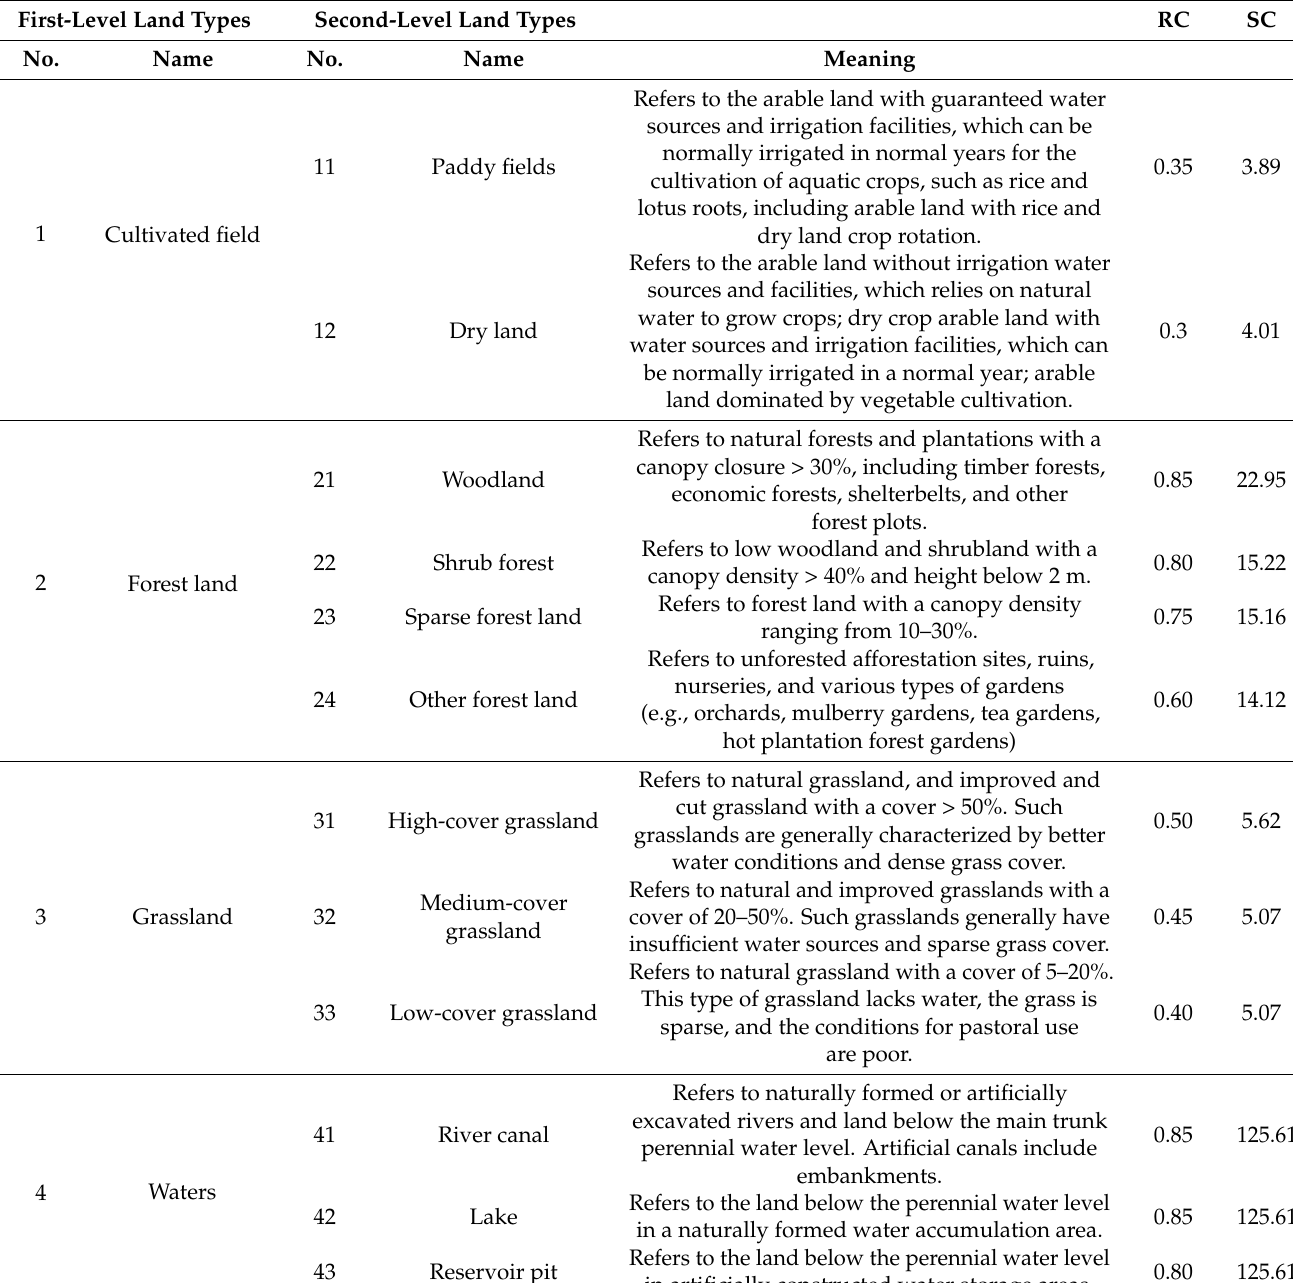
Table 1. Land use classification and meaning, ecosystem resilience (RC), and services coefficient